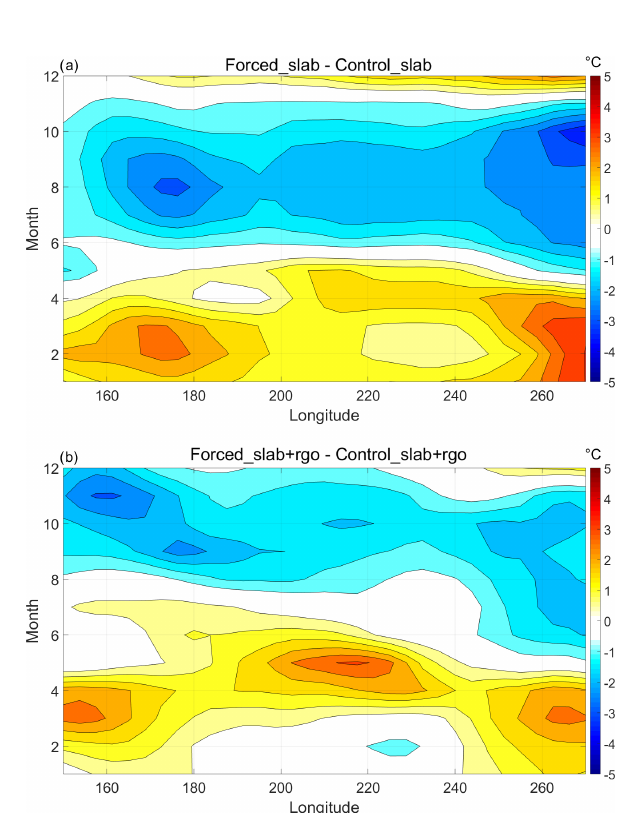
Figure 10. Equatorial Pacific Ocean (2 ◦ S–2 ◦ N, 150–270 ◦ E) de- meaned SST anomalies seasonal cycle for (a) Forced_slab and (b) Forced_slab + rgo experiments. Contour interval: 0.2 ◦